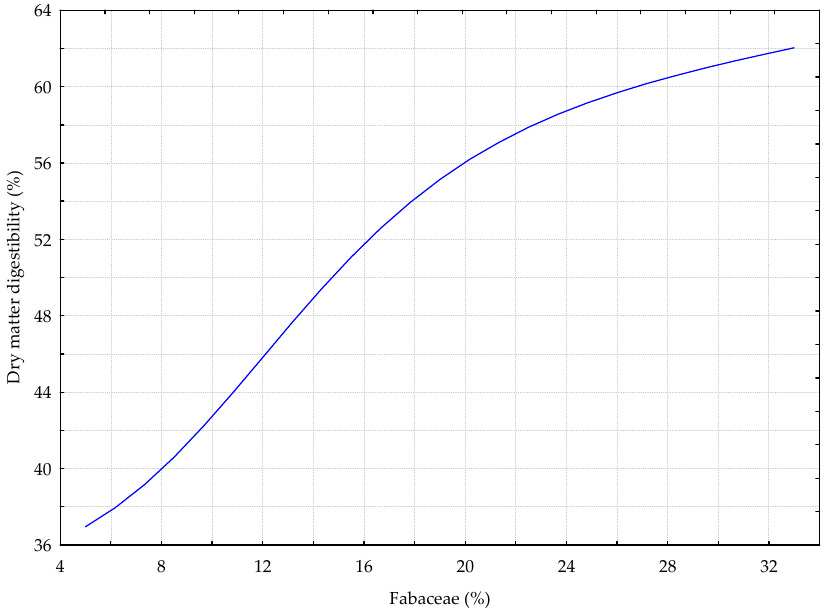
Figure 11. The DIG_GC model. The response chart for variables %_L (rank 1) and %_DMD. Figure 11 shows the data referring to the dependence between the percentage of and the digestibility of the dry matter from the sward with the predominance of grasses and red clover (DIG_GC model). An increase in the percentage share of legumes (%_L) caused an increase in the digestibility of the green forage dry matter. The relation between the average daily air temperature (T_AV)—rank one and the protein yield is presented on Figure 12. An increase in the average daily air temperature to about 9.5 ◦ C stimulated the accumulation of protein in the sward with the predominance of grasses and red clover. When this value was exceeded, the protein yield remained at a steady level of about 0.3 t · ha − 1 .